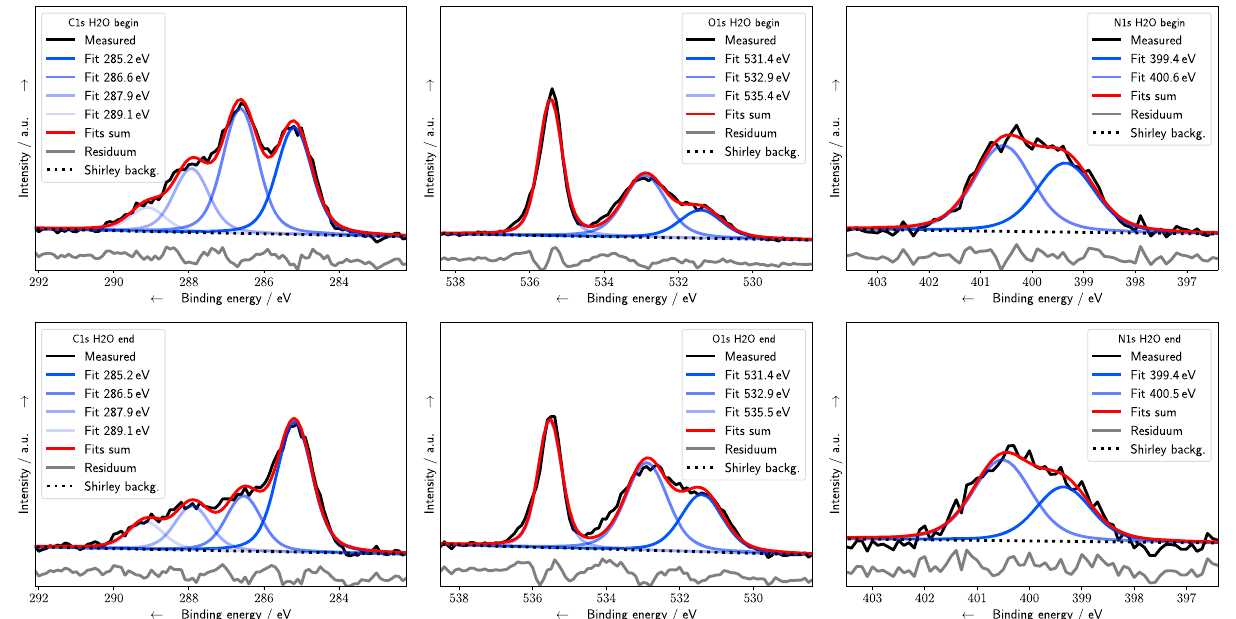
Fig. 3 XPS spectra under water atmosphere. C1s (left column), O1s (central column), and N1s (right column) spectra are shown at the beginning (top row) and end (bottom row) of the exposure. In addition, Voigt peak fi ts (blue), the sum (red), the Shirley background (black dotted curve), and fi tting residuals (gray) are also shown. Residuals were shifted to lower y